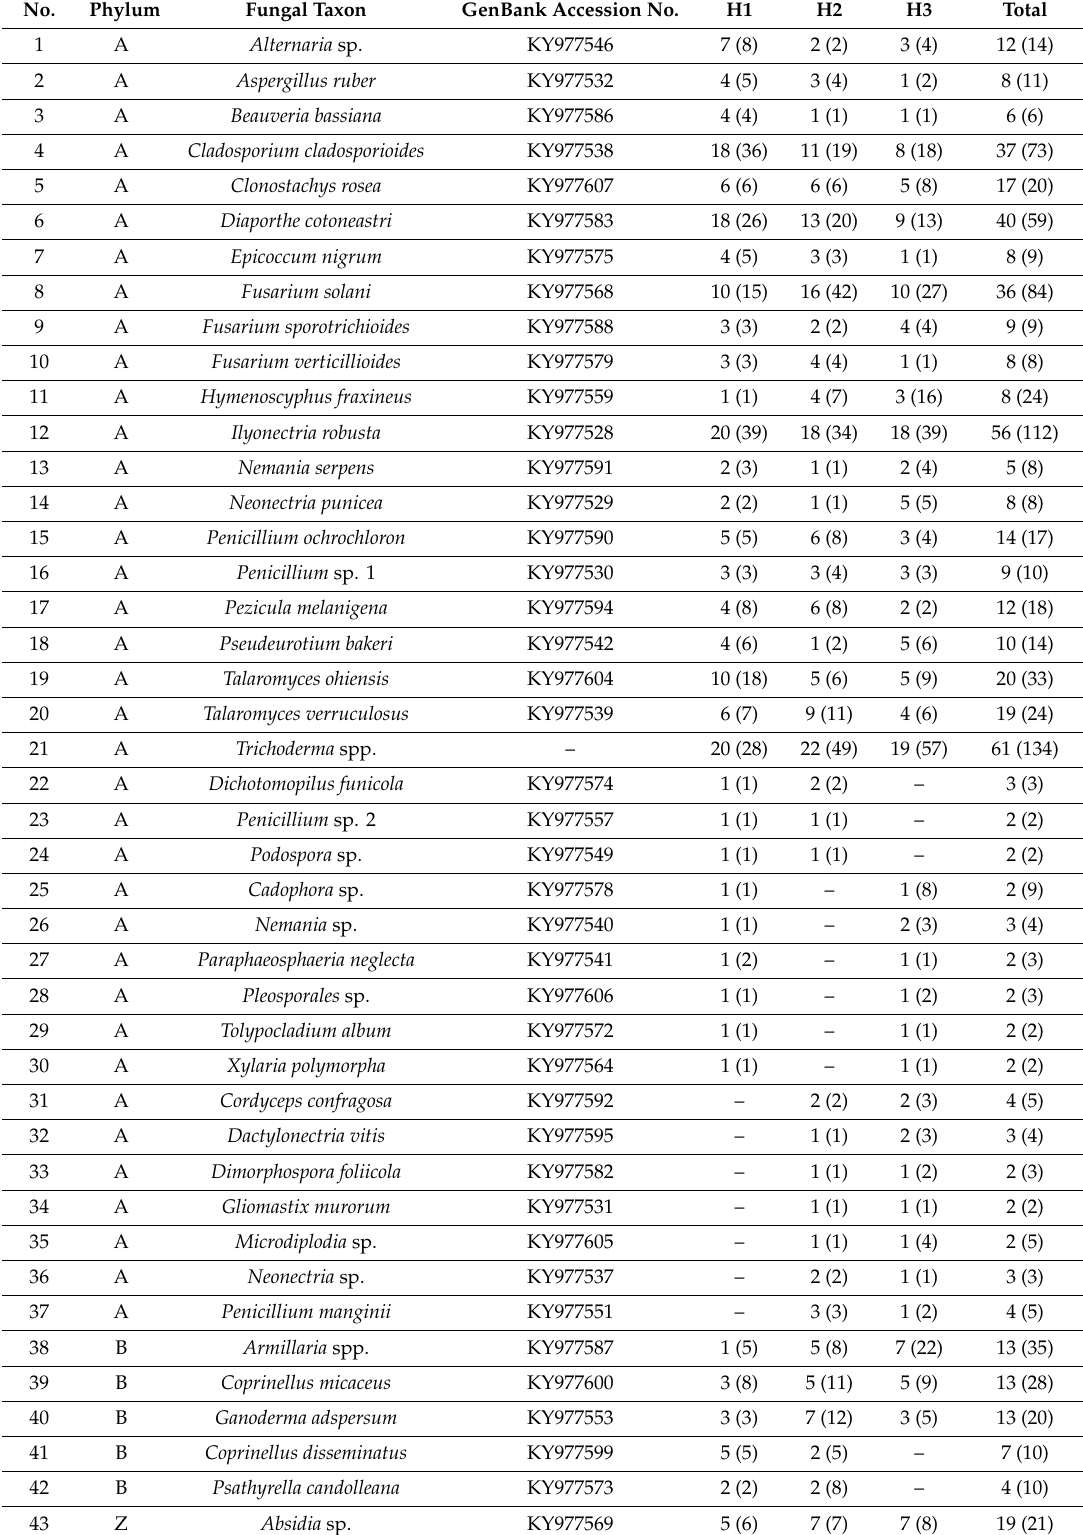
Table 1. Number of colonized Fraxinus angustifolia trees and obtained isolates (in brackets) in three health categories for each fungal taxon found in more than one category (H1 = crown defoliation ≤ 25%, H2 = crown defoliation 26–60%, H3 = crown defoliation 61–99%. A = Ascomycota, B = Basidiomycota, Z =